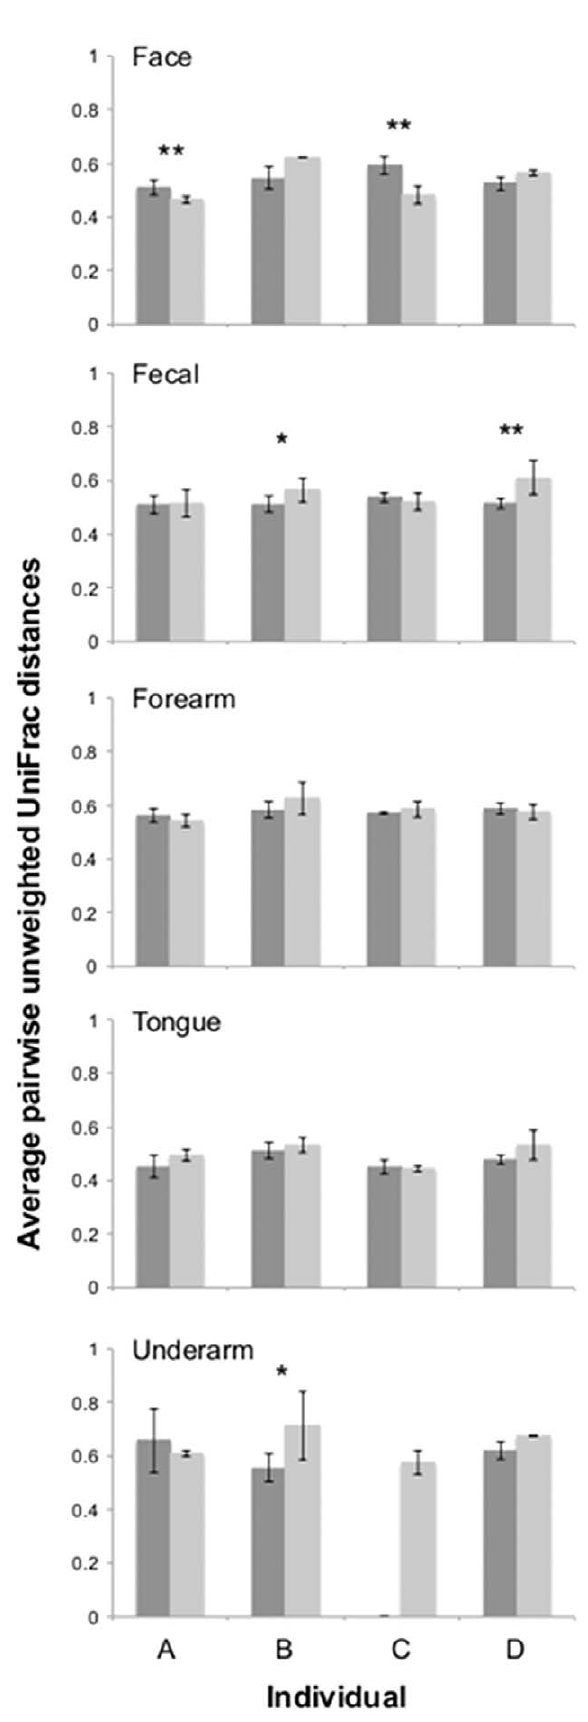
Figure 5. Variation of unweighted UniFrac distances of replicate samples using the direct PCR (dark grey) and standard extraction/purification (light grey) protocols. Bars with asterisks denote comparisons that were statistically significant within an individual (t-test, one asterisks p # 0.05, two asterisks p # 0.01). No statistical differences between methods across individuals were observed for any body habitats (paired t-test, p . 0.05). Error bars are 6 one standard